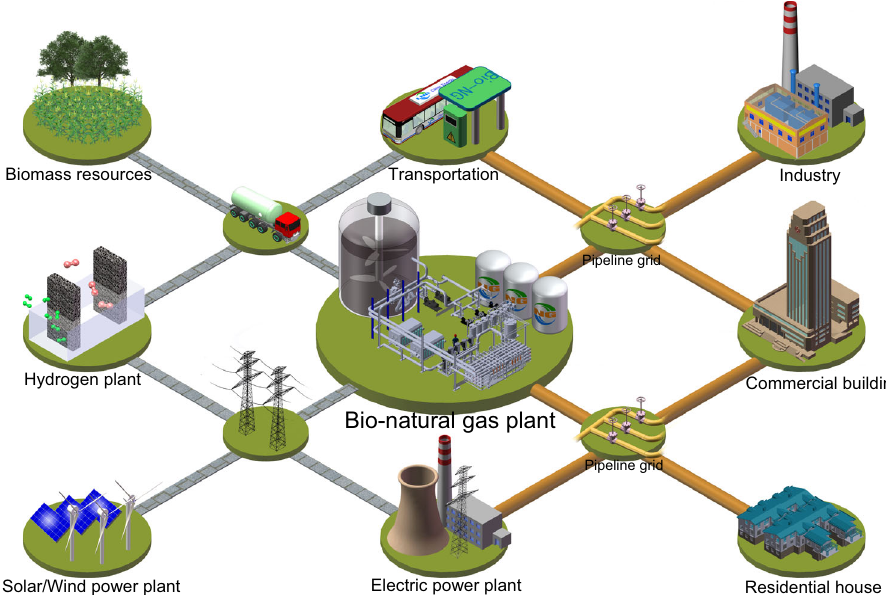
Fig. 4 Conceptual diagram for bio-natural gas production from biomass. It is comprised of the production and application of bio-natural